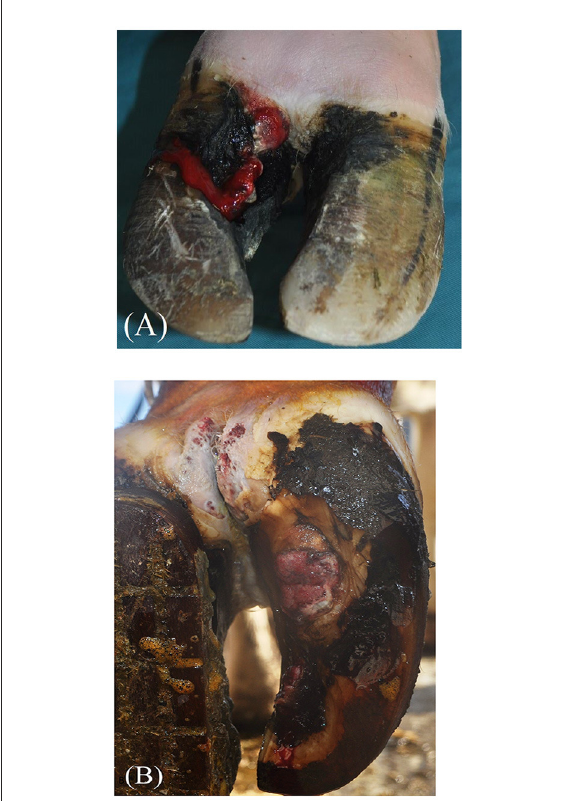
FIGURE1 Gross pathology of bovine digital dermatitis (BDD)-associated axial horn fissure [BDD-HFA; (A) ] and BDD-associated sole ulcer (BDD-SU) before treatment (B) .